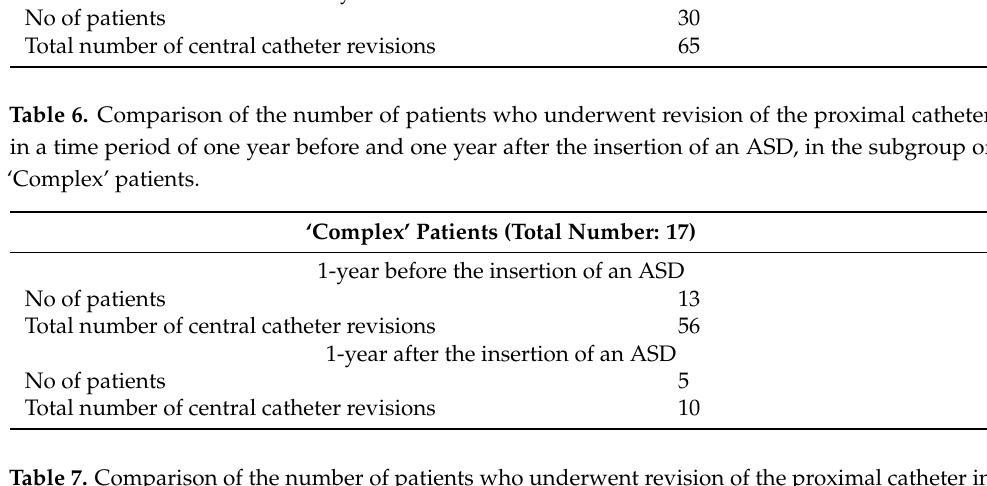
Table 7. Comparison of the number of patients who underwent revision of the proximal catheter in a time period of five years before and five years after the insertion of an ASD, in the subgroup of ‘Complex’